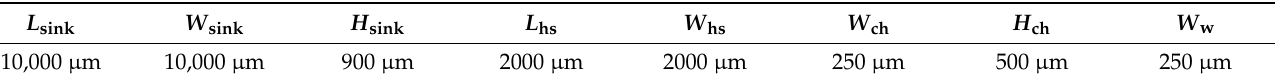
Table 1. Dimensions of